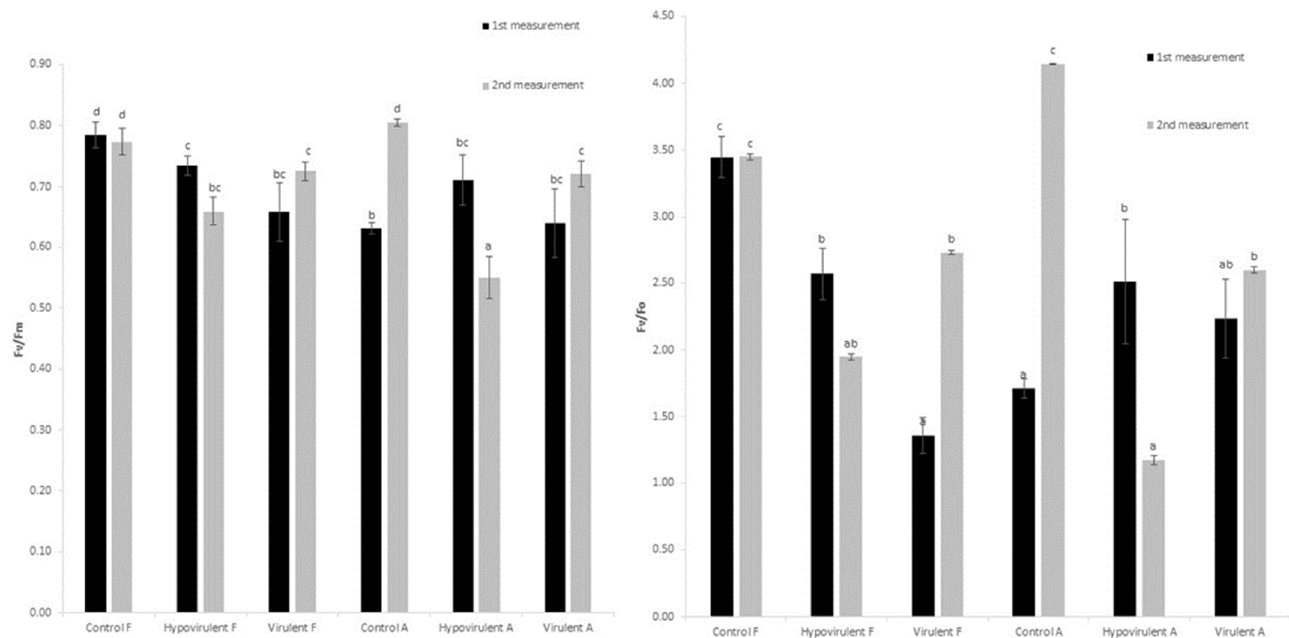
Figure 2. Measured chlorophyll- a fluorescence (variable fluorescence/maximum fluorescence) at 21 and 42 days after inoculation with hypovirulent and virulent fungal strains. Values are means ± SD, n = 5. Significant differences among samples based on the Tukey-HSD test. F: leaf above the infection, A: leaf under the infection.